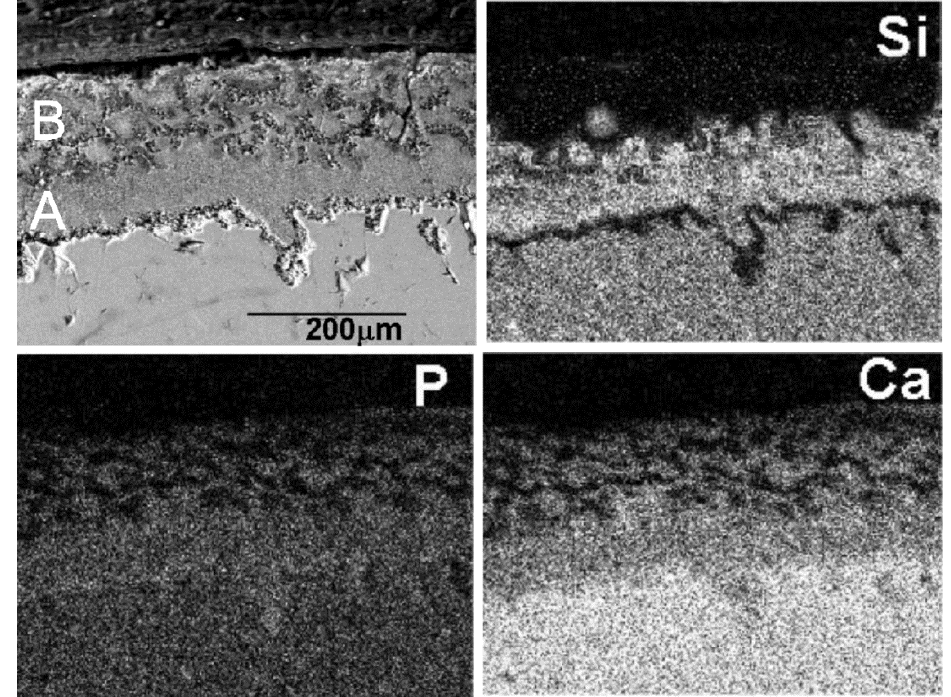
Figure 8. X-ray elemental maps of Si, Ca, P and SEM image of a cross-section of Bioeutectic implant after 15 months of implantation. ( A , B ) indicate places where micro-Raman spectra were